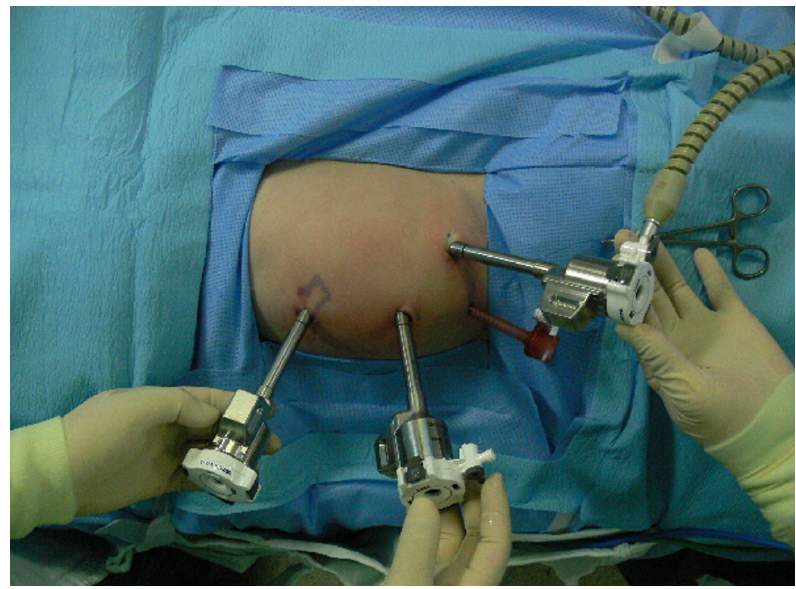
Figure 2. Port placement in 10-months-old infant with ureteropelvic junction obstruction on the left side. Three 8 mm robotic arm ports are placed in the abdomen. Subxiphoid and left lower abdominal areas are the robotic arm ports for left and right hands. Camera port is inserted on the supraumbilical area. Suprapubic 5 mm port is used as an assistant port.